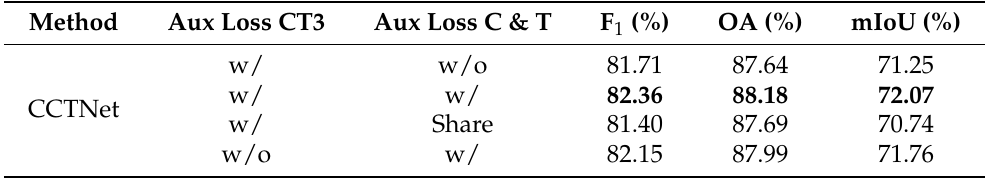
Table 6. Ablation experiments for the auxiliary loss